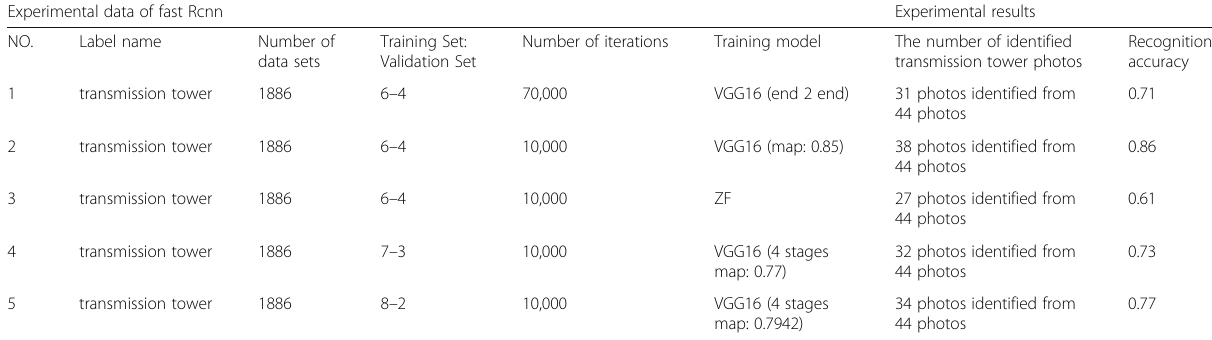
Table 2 The experimental data of fast Rcnn and experimental results Experimental data of fast Rcnn Experimental results